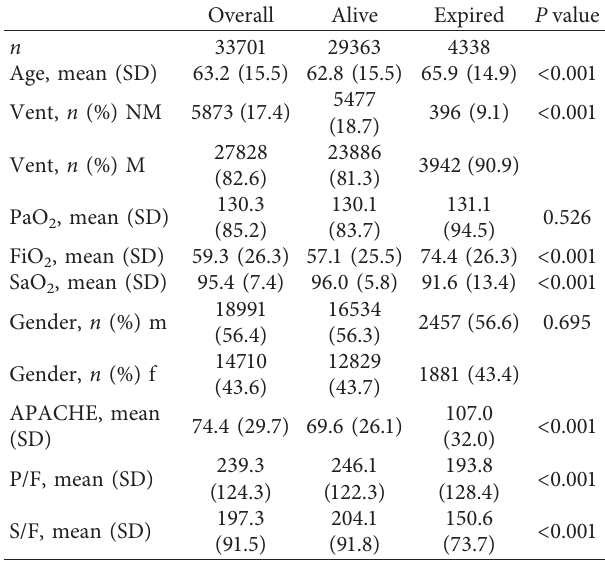
Table 1: Summary statistics of demographics and features.